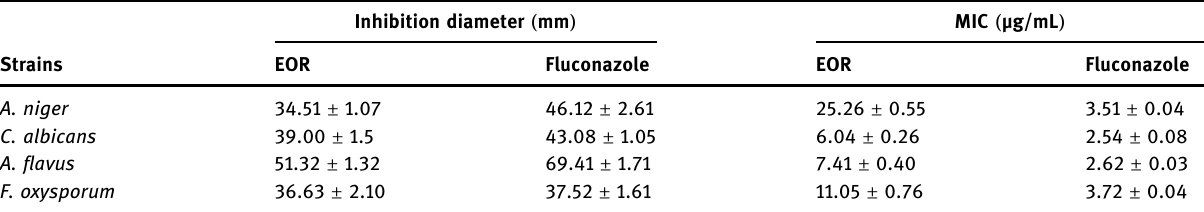
Table 4: Results of antifungal activity of EOR by use of disc and microdilution